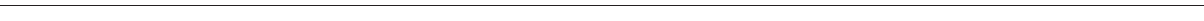
FIGURE 1 | demonstrating the discontinuous expression of VE-Cadherin junctions (green) in LVs as compared to blood vessels. This lymphatic organization of junctions is characteristic of lymphatic endothelial cells from initial lymphatic capillaries. (B) Representative 3D-reconstructed confocal images of initial lymphatic vessel (LYVE-1, red) segments and their associated staining for several glycan chains. The images show that lymphatic glycocalyx contains HS (anti-HS Ab), α -D-Galactosyl moieties (IB4), sialic acid α 2,3-linked (MAL-1) glycans, and N-Acetylglucosamine moieties (sWGA), whilst sialic acid α 2,6-linked glycans (SNA), or hyaluronan (HA) minimally detected. (C) Quantification of the mean fluorescence intensity of HS, IB4, MAL-1, sWGA, SNA, HA as quantified on the lymphatic vessel using IMARIS software. (D) Linear relationship between the mean vessel size and the mean fluorescence intensity of multiple glycocalyx binding proteins (anti-HS Ab, IB4, MAL-1, and sWGA). Each point represents an individual vessel from cremaster muscles. Dotted curved lines in the correlation plots represent 95% confidence interval. Bar = 50 µ m. Images are representative pictures from at least 8–10 vessels/animals, with at least 5 animals per group. Significant differences between lymphatic MFI and background MFI are indicated by asterisks: * P < 0.05, ** P < 0.01, **** P <